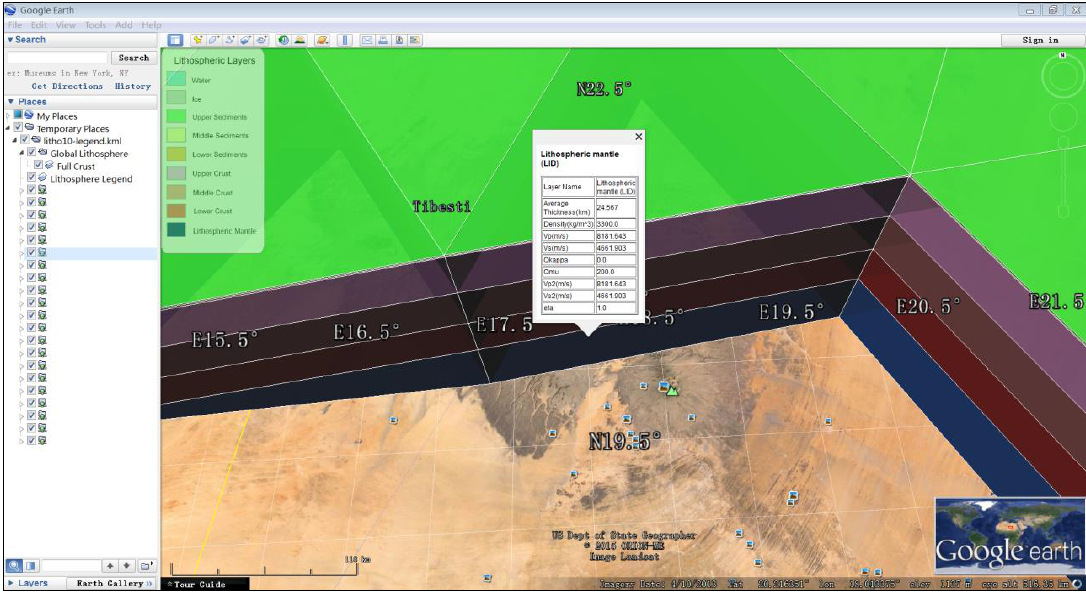
Figure 4. Displaying the lithospheric models with the detailed level, and querying the property information associated with an interior sublayer within a lithospheric cell.